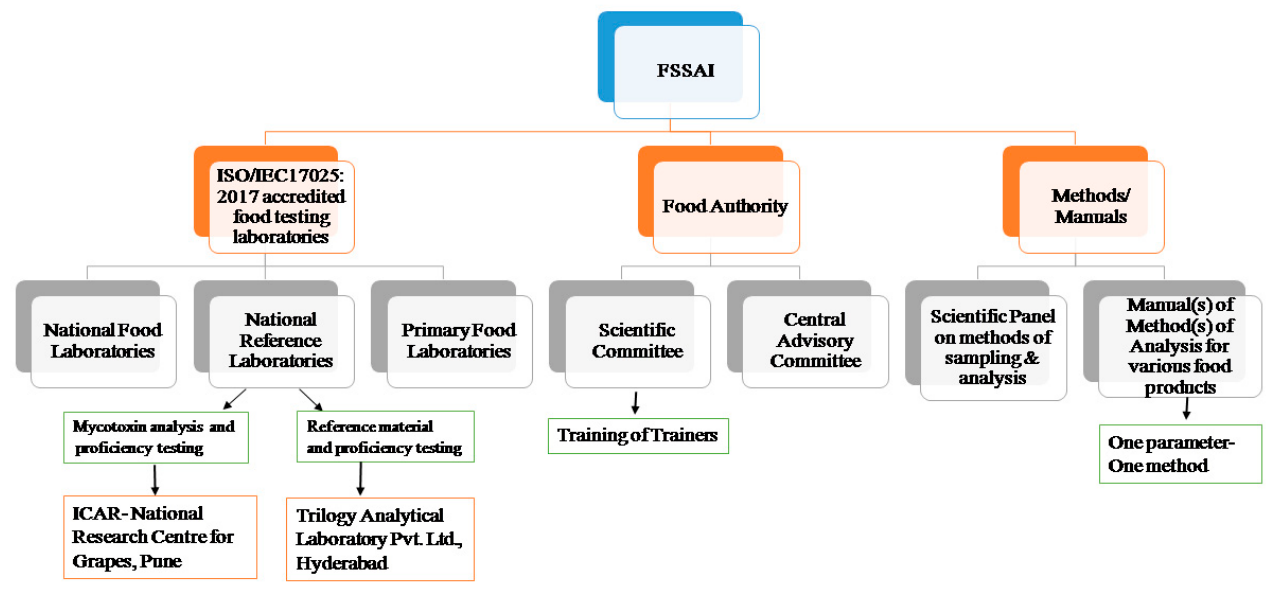
Figure 1. Schematic view of role of FSSAI in capacity building trough food testing laboratories, scientific community, and analytical methods to combat mycotoxin spread in India.